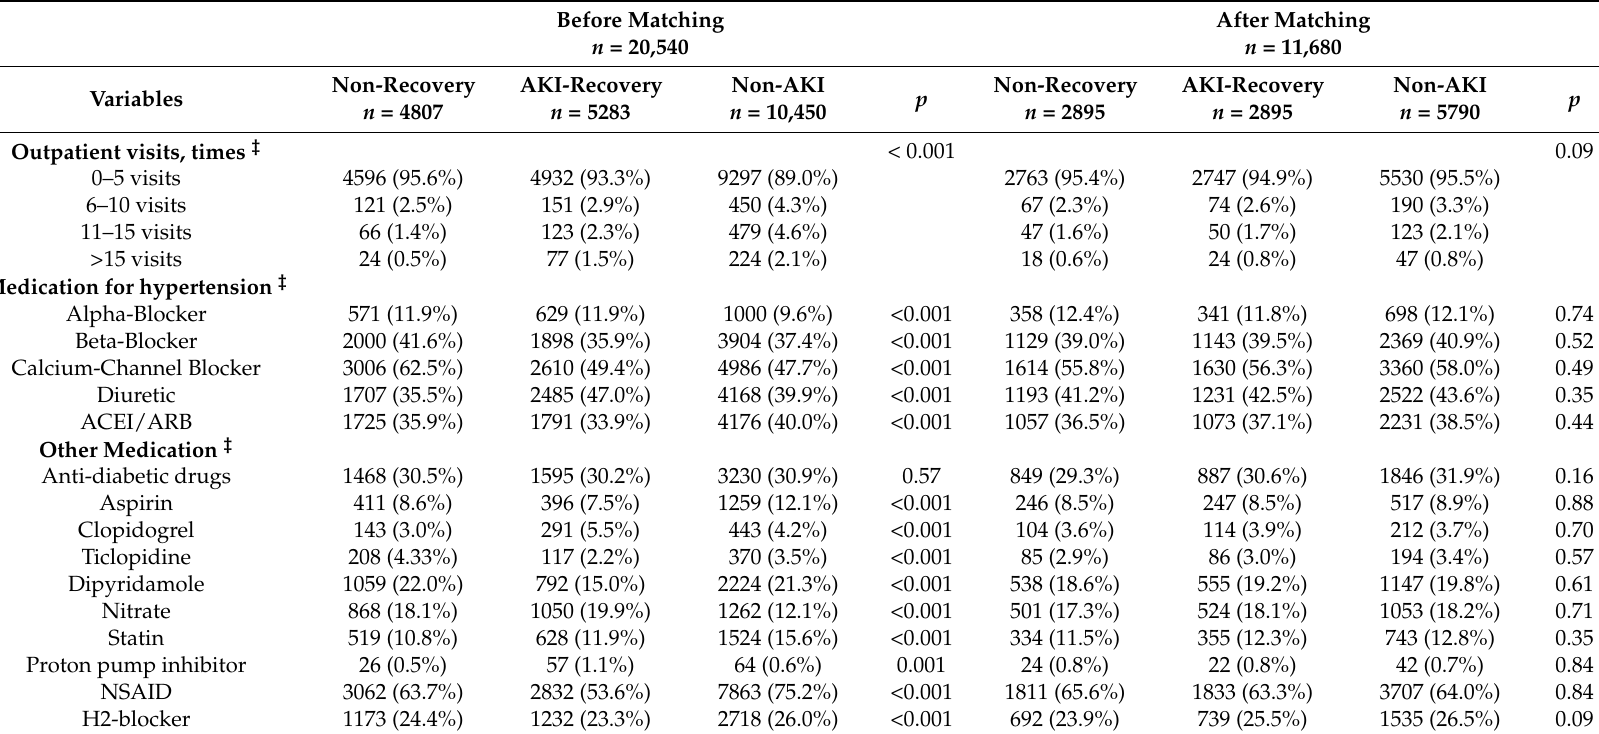
Table 2. Comparisons of the variables within one year following hospital discharge and outcomes among the three